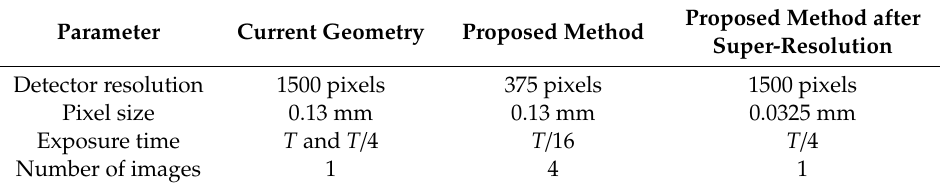
Table 1. Simulation’s parameters